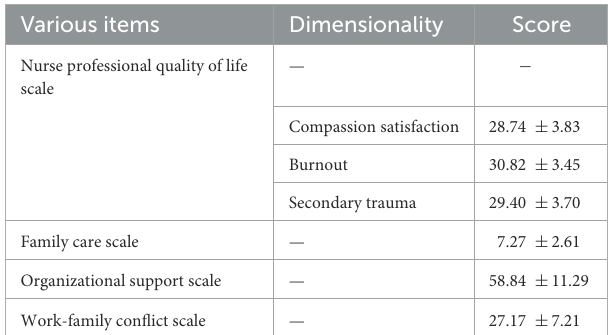
TABLE 2 Clinical nurses’ scores on each scale and on each dimension ( n =